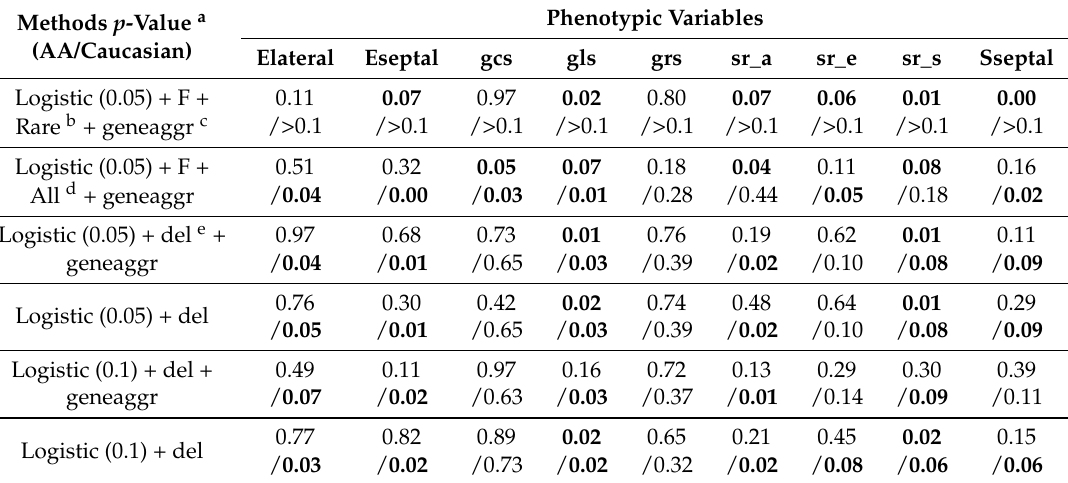
Table 3. Summary of Kruskal–Wallis test results for each phenotypic variable using different combination of filtrations.